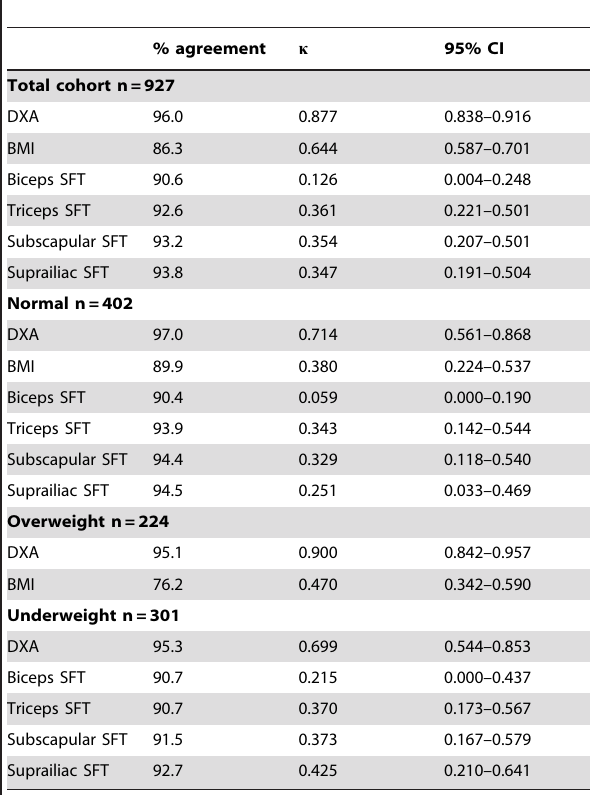
Table 3. Cross-tabulation statistics for evaluation of DXA, BMI and SFTs against 4C FM.